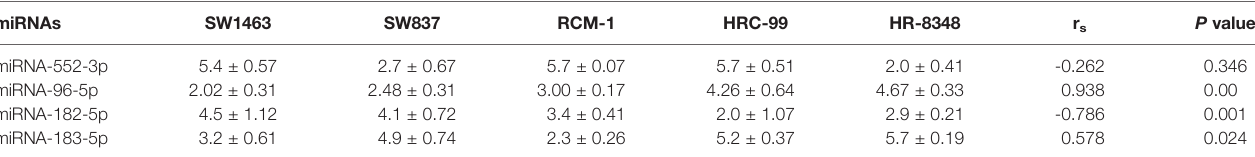
TABLE 3 | Expression of miRNAs positively correlated with irradiation resistance in different cell lines. miRNAs